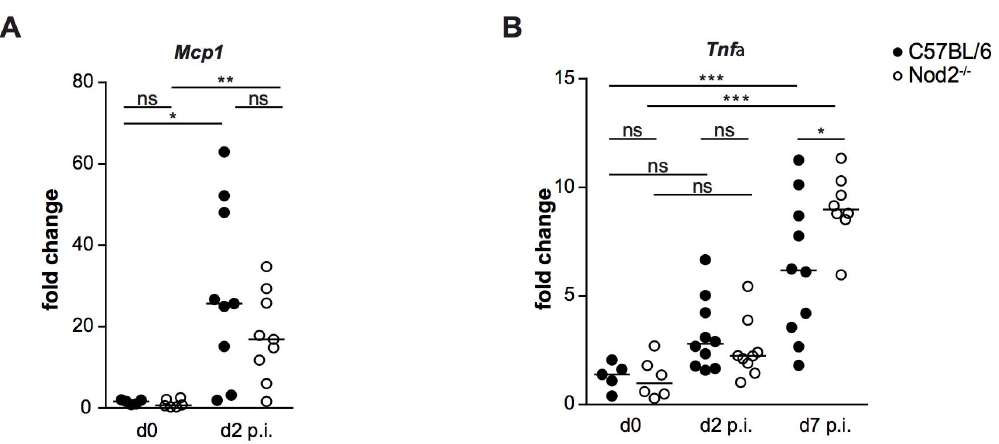
Figure 3. S. Typhimurium D msbB infection induces pro-inflammatory gene expression in C57Bl/6 and Nod2 2 / 2 mice. Gene expression of mcp1 and tnf a , were measured by quantitative real-time PCR. Data were normalized to gapdh expression levels; Statistical analysis: 1way ANOVA with Tukey’s multiple comparison post-test. * p , 0.05; ** p , 0.01; *** p , 0.001; ns: not